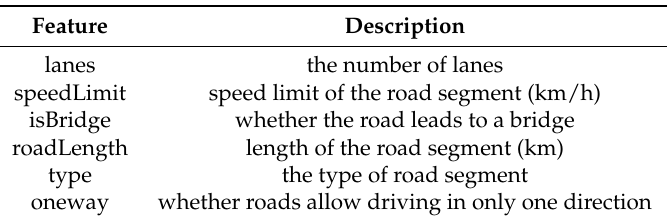
Table 1. Road-related